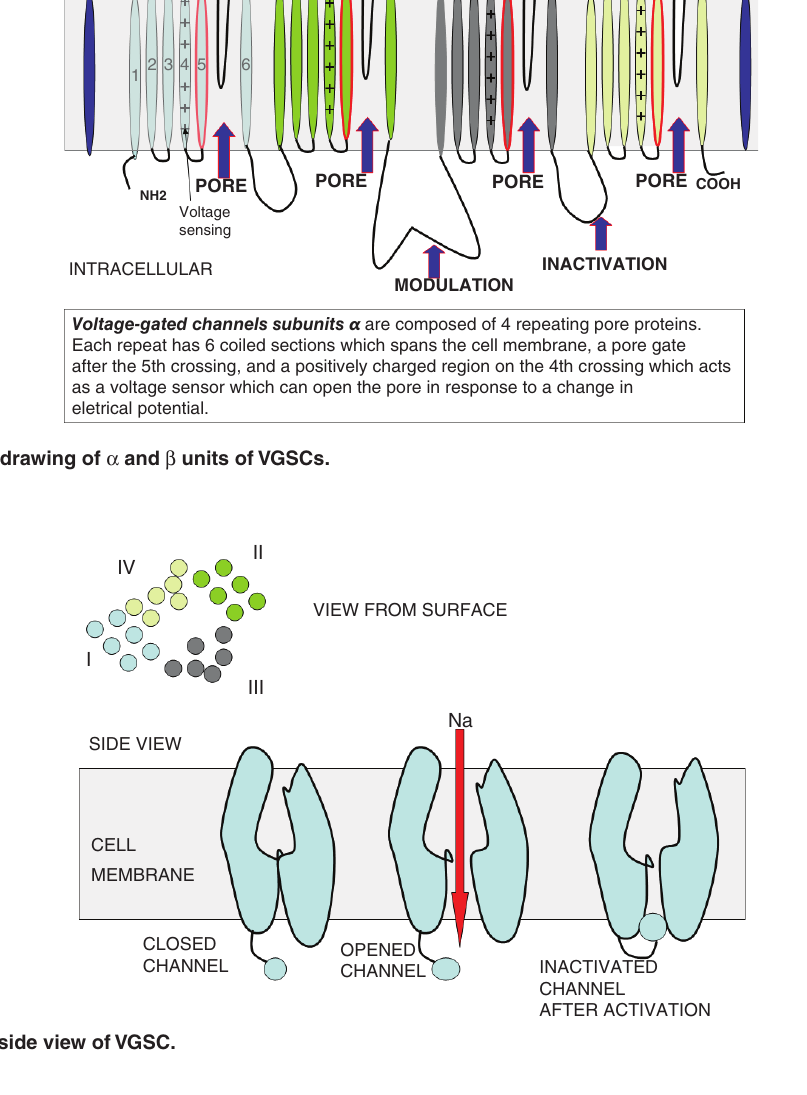
Figure 3. Surface and side view of